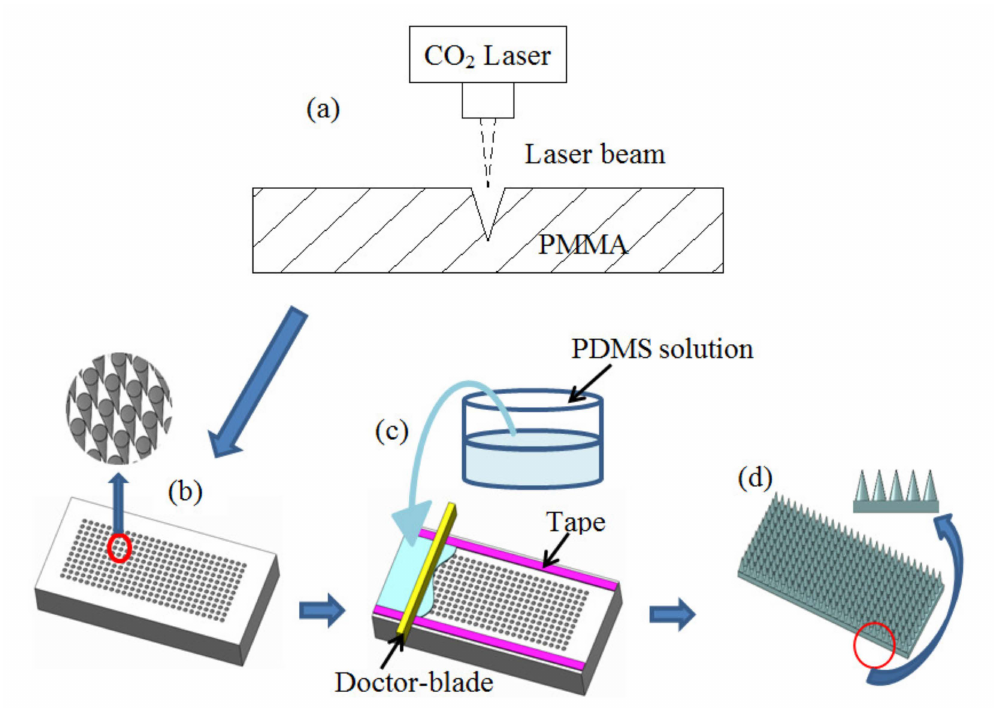
Figure 7. Schematic process flow of the microneedle-PDMS (MN-PDMS) film: ( a ) CO 2 laser ablated PMMA to produce the MN-hole array, ( b ) the micro-holes array mold and an enlarged image of MN array, ( c ) the PDMS solution poured into the micromold and curing, and ( d ) the PDMS was cooled down to room temperature, peeled off from the mold, and a magnified image of the MN structure from the front.